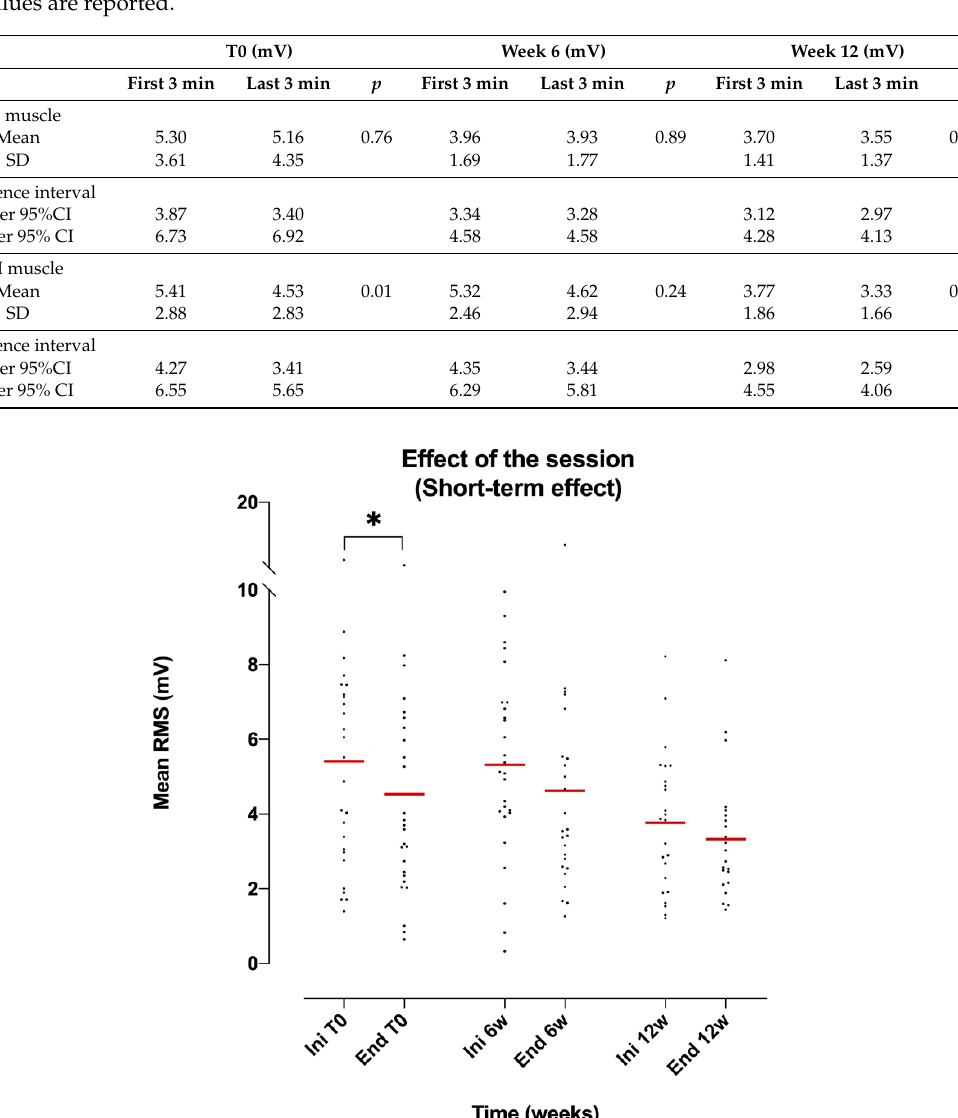
Table 5. E ff ect of the session (short-term e ff ect) on the mRMS values (in mV) in the RA and AM muscles at each treatment time (initial session, at week 6, and at week 12). Tukey multiple-comparison post-test p -values are reported.